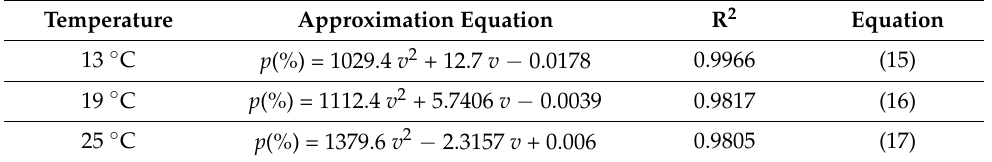
Table 2. Trend lines for filter bed expansion as a function of flushing